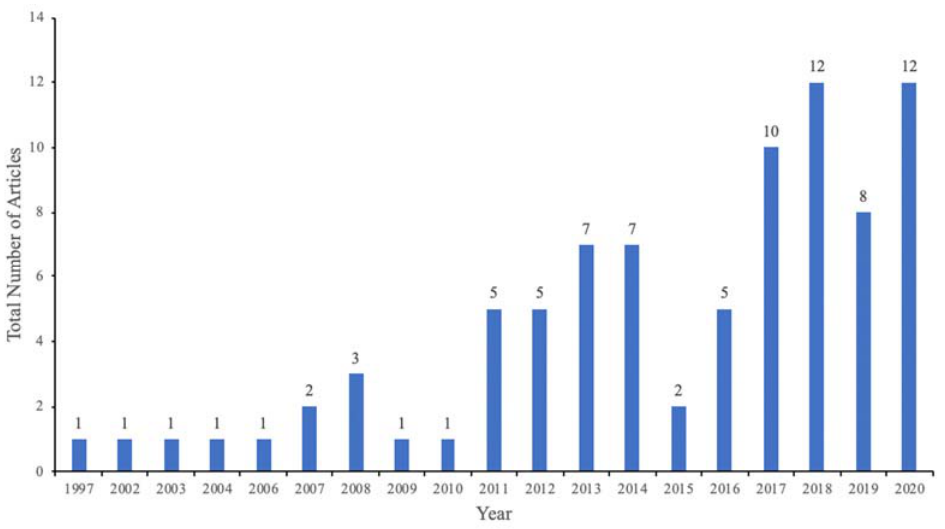
Figure 3. Years of publication of the 85 articles included in the scoping review of coastal adaptation to climate change using Ecosystem ‐ based Adaptation